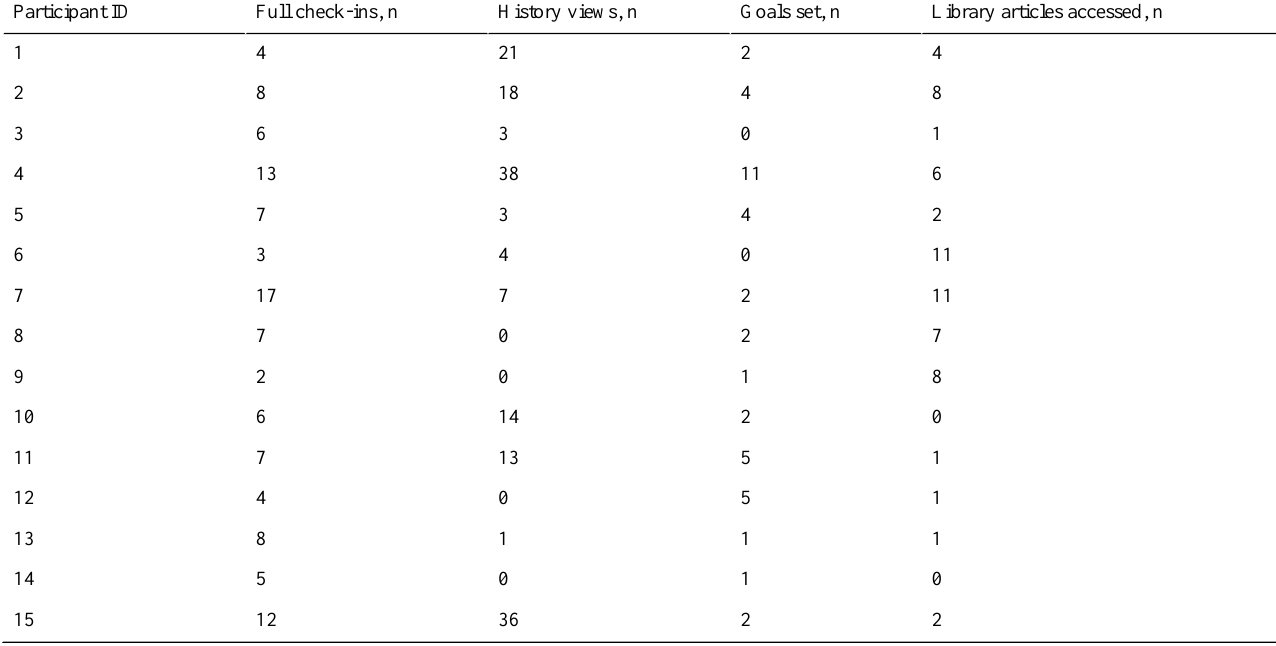
Table 3. Individual participant engagement data for the use of the iCanCope with Pain app over 7